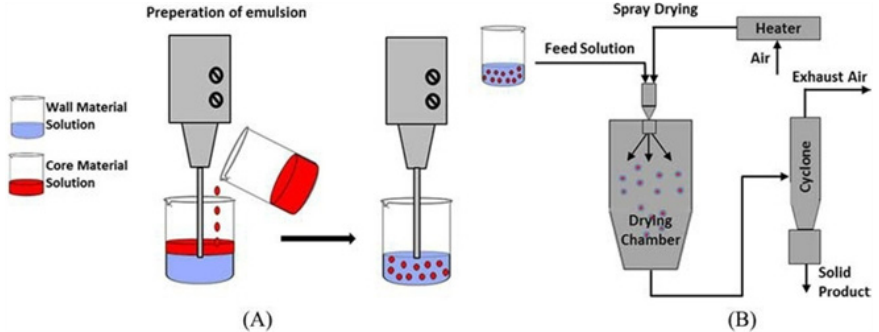
Figure 4. ( A ) Preparation of emulsion; ( B ) spray ‐ drying (reproduced with permission) [185].